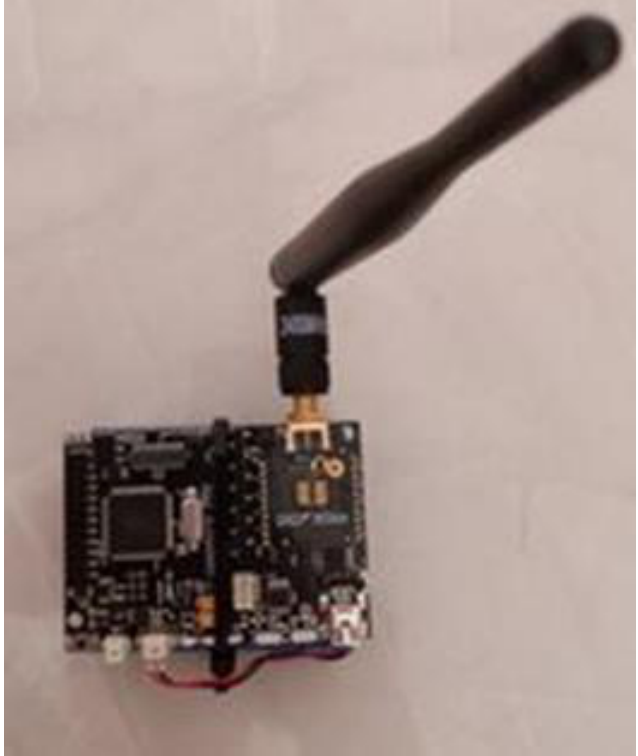
Figure 14. Waspmote device equipped with the 802.15.4 module.